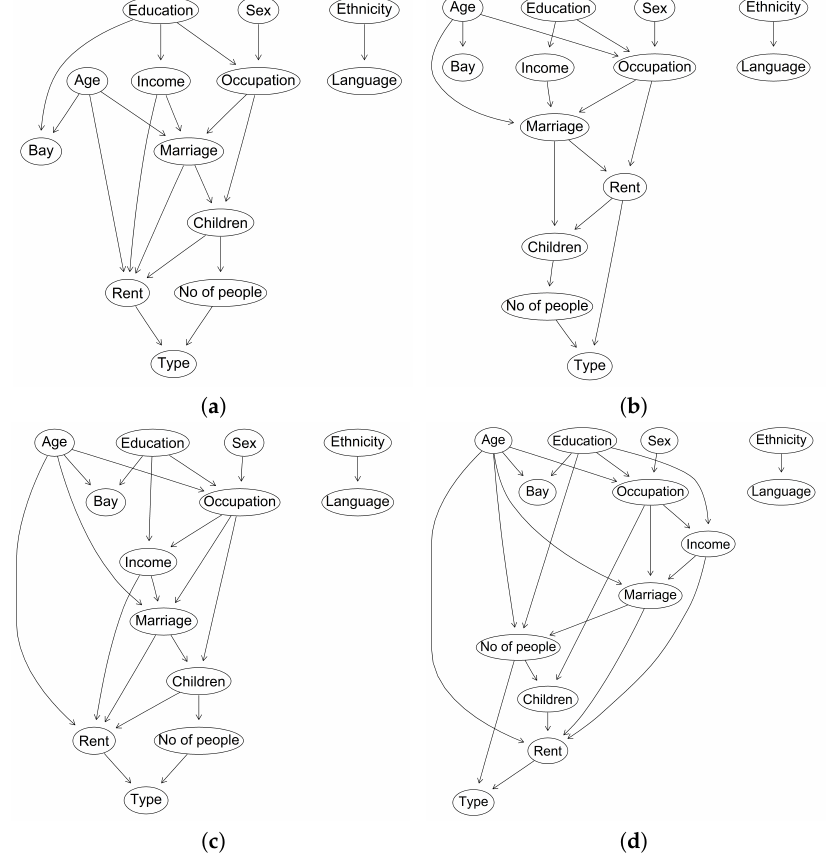
Figure 13. Income data. Estimated BNs using ( a ) FEDHC, ( b ) PCHC, ( c ) MMHC-1 and ( d )